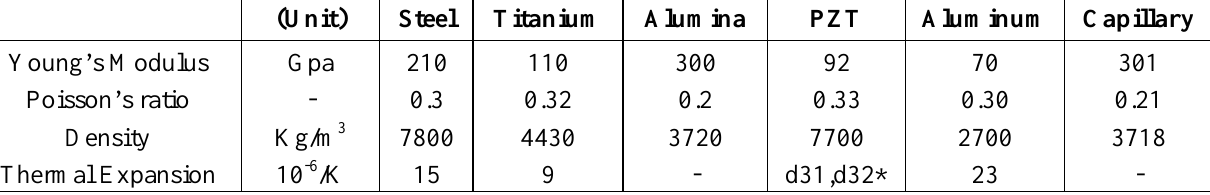
Table 1. Material properties chosen for the